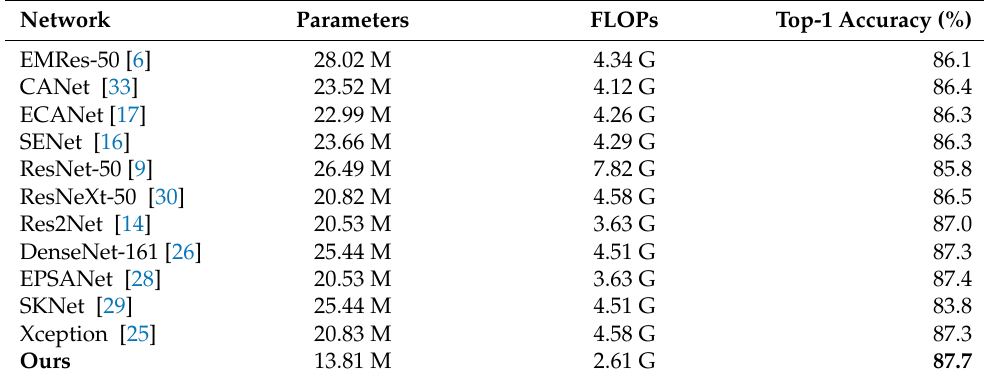
Table 7. Comparison experimental results on the clothing style classification dataset